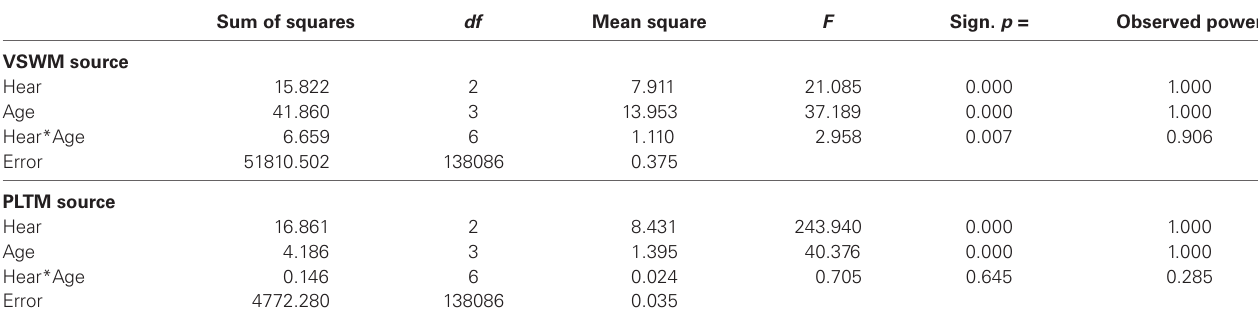
memory task. Note that as the x -axis is the actual mean ages in the age-groups, the slopes of the lines between the age-groups are on a comparable scale. This also explains why the y -values are not on the same vertical age-line.